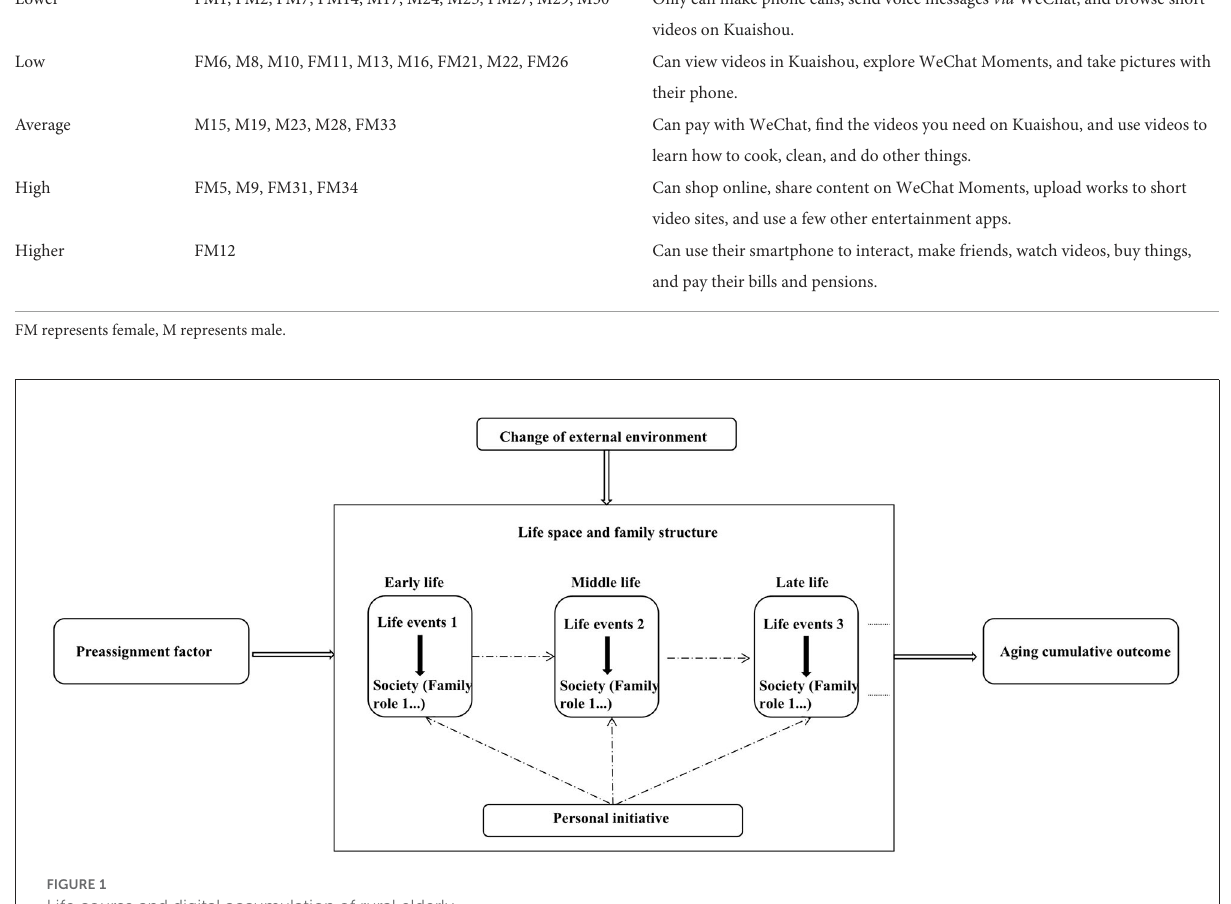
RQ2: What elements in the life courses of an individual inhibit the process of digital inclusion, and what elements promote